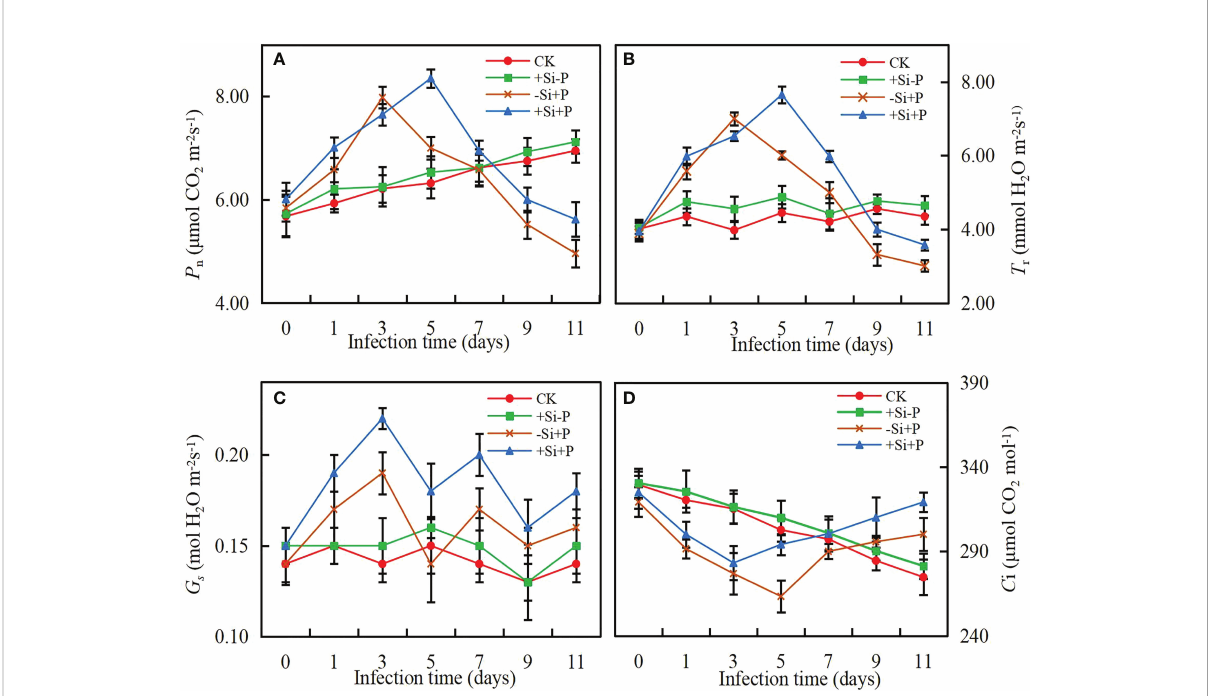
FIGURE 2 Effects of Si application and Pga inoculation on photosynthetic parameters of oat leaves. (A) , net photosynthetic rate ( P n ); (B) , stomatal conductance ( G s ); (C) , transpiration rate ( T r ); (D) , intercellular CO 2 concentration ( C i ). CK, no Si application and no Pga inoculation; +Si-P, 1.5 mmol·L – 1 Si application and no Pga inoculation; -Si+P, no Si application and Pga inoculation; +Si+P, 1.5 mmol·L – 1 Si application and Pga